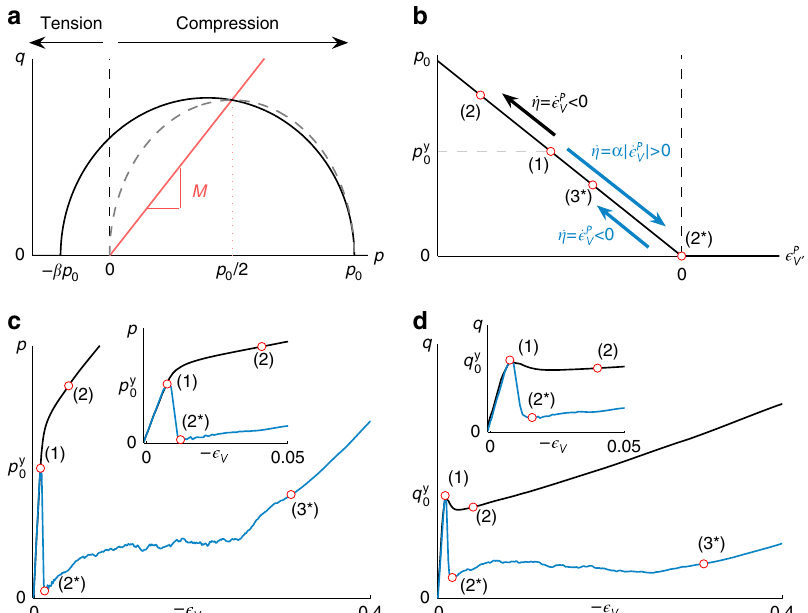
Fig. 1 Overview of the elastoplastic model. a Cohesive (black line) and cohesionless (dashed gray line) cam clay yield surface in the p – q space. The red line (cid:3) (cid:4) corresponds to the Critical State Line. b Illustration of the hardening models p 0 ϵ P V (for the slab) and p 0 ( η ) (for the weak layer): the black arrow shows the (cid:3) (cid:4) classical hardening law used for the snow slab in which p 0 increases in compression _ ϵ P V < 0 ; the blue arrows represent the new softening model for the (cid:5) (cid:5) (cid:3) (cid:4) (cid:5) (cid:5) weak layer for which p 0 decreases under compression _ η ¼ α _ ϵ P V until ϵ P V ¼ 0 after which the classical hardening law is used with β = 0. c Typical p – ϵ V > 0 curve obtained for the uncon fi ned compression of the weak layer in experiment number 2 (see Methods section for model parameters) for the classical hardening law (in black) and the new softening one (in blue). d Same as c but for the q – ϵ V curve. In c and d , p and q in the weak layer (blue curves) do not perfectly reach zero after softening due to a loss of homogeneity (failure